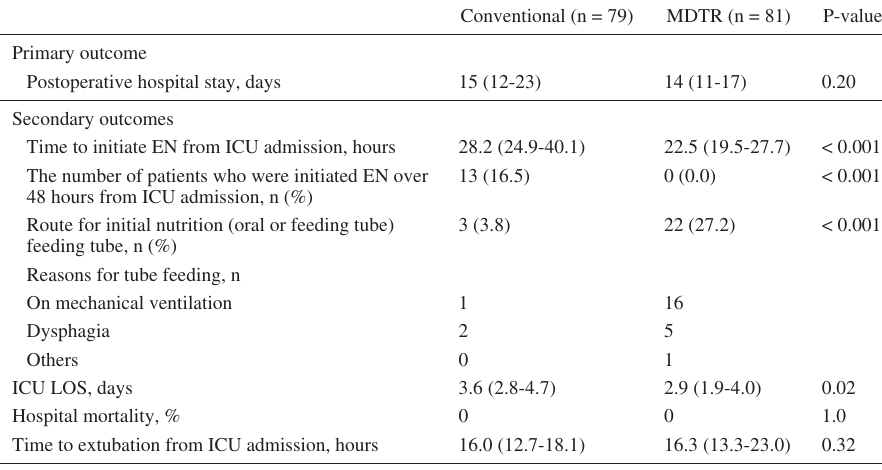
Table 2. Clinical